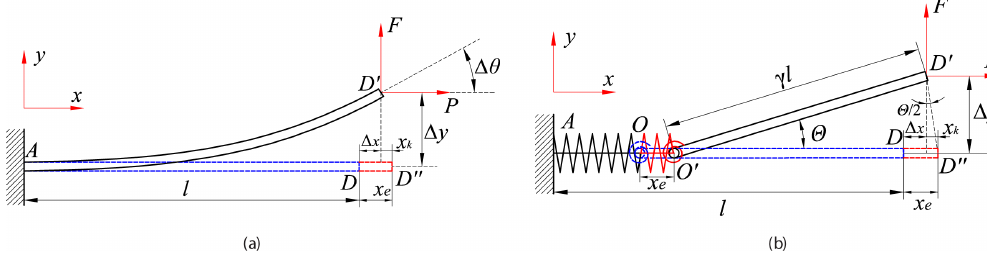
Figure 2. Fixed-free compliant beam. (a) Deflected configuration. (b) MPRB model.